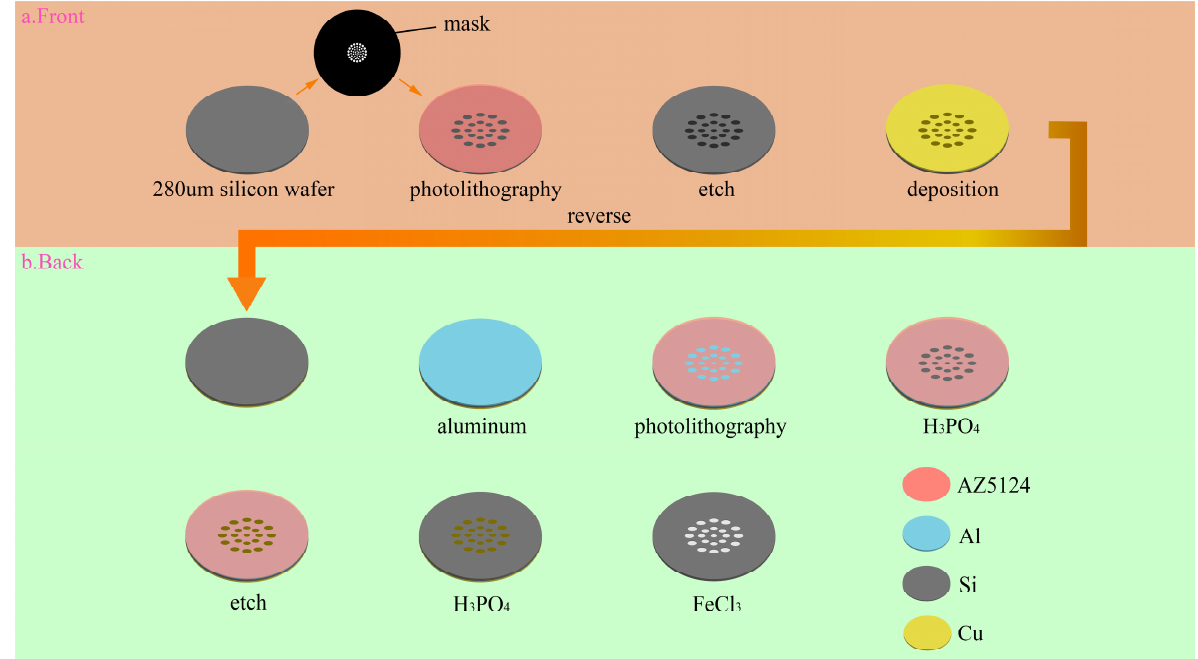
Figure 4. Micropore array silicon wafer preparation process.